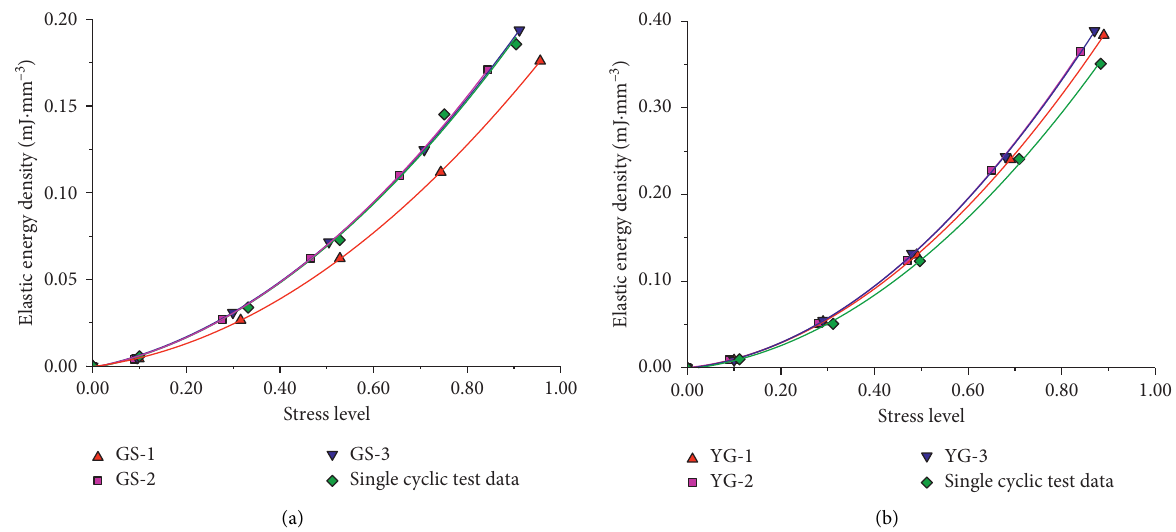
Figure 8: Variation tendency of the elastic energy density with the stress levels. (a) Green sandstone; (b) Yueyang granite. Table 3: Fitted functions between the energy density and stress level. Specimen no.